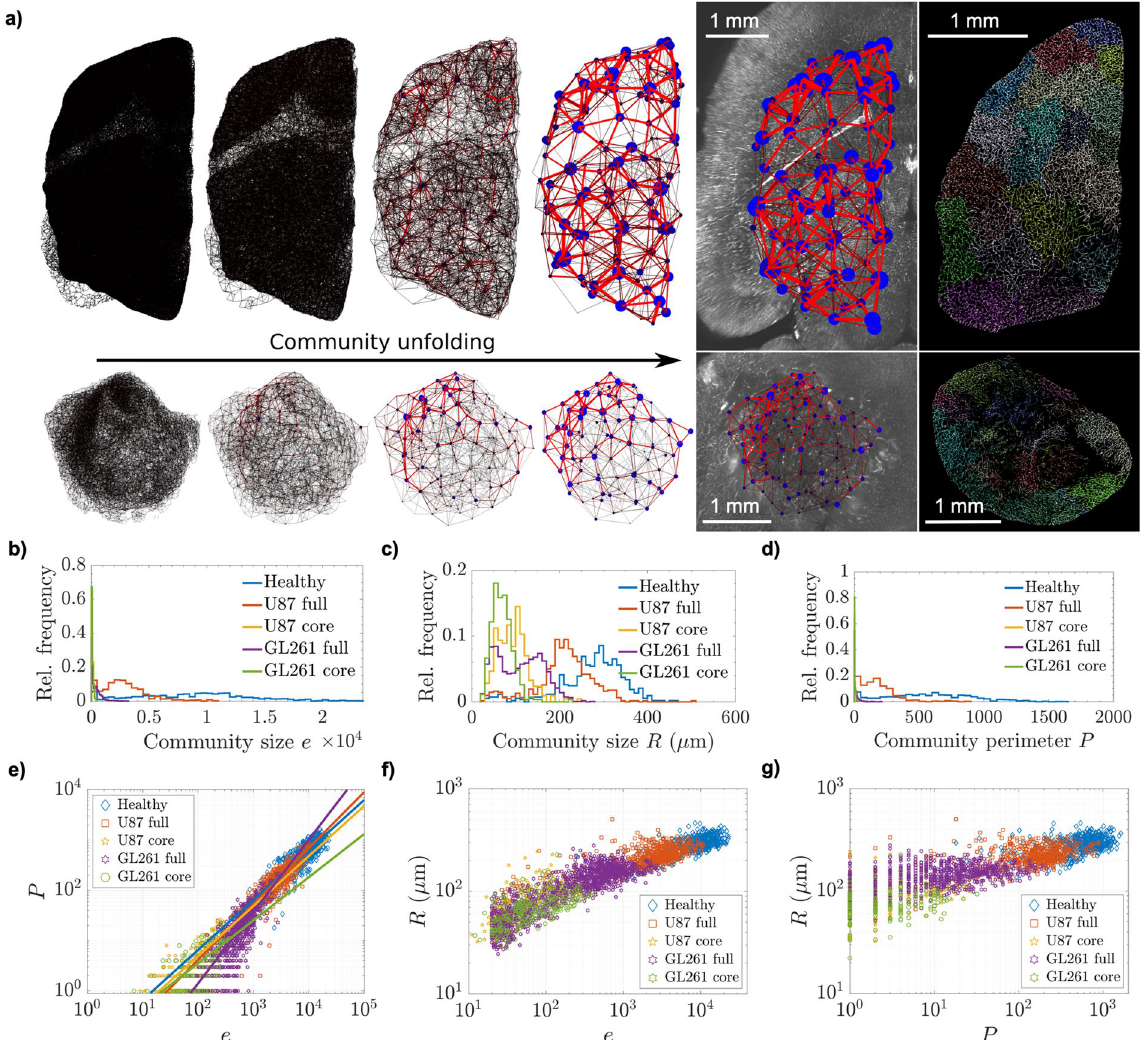
Figure 3. Modular network structure. ( a ) Schematic graphs of the community unfolding process on an entire vascular network in a healthy brain hemisphere (top) and full U87 glioblastoma (bottom). Each level of partitioning represents a local maximum in modularity Q , attained with increasing community sizes. The rightmost graph shows the clustering scheme with global maximum modularity over a central slice of the original SPIM-image. Communities are depicted by circles with diameter and brightness (blue) proportional to cluster size e j , while the weight of a connection (the number of intercommunity vessel segments) is encoded in → the edge thickness and brightness (red). Cluster positions are given by their centroid r j . The specimens 3 and = . V 12 87 mm 3 in healthy control encompass comparable (shrunken) tissue volumes of = . V 12 11 mm h g and tumor tissue, respectively (excluding ventricular space in the healthy brain, blinded for analysis). To the right of the partitioning chains, projections of 100 μ m thick sections of the skeletonized vessel data show community affiliation (at global maximum Q ) through the color of each branch segment. Relative distributions of community size properties from all specimens follow, namely ( b ) internal number of edges e , ( c ) mean physical extent R , and ( d ) community perimeter P . Panel (e) presents the relationship between a community’s number of internal edges e and its perimeter P . Linear fits to the log-log-representation are plotted in lighter colors over the datapoints, presenting slopes ξ . The following plots illustrate the relationships between ( f ) community edges e and mean physical extent R , as well as ( g ) perimeter P and R